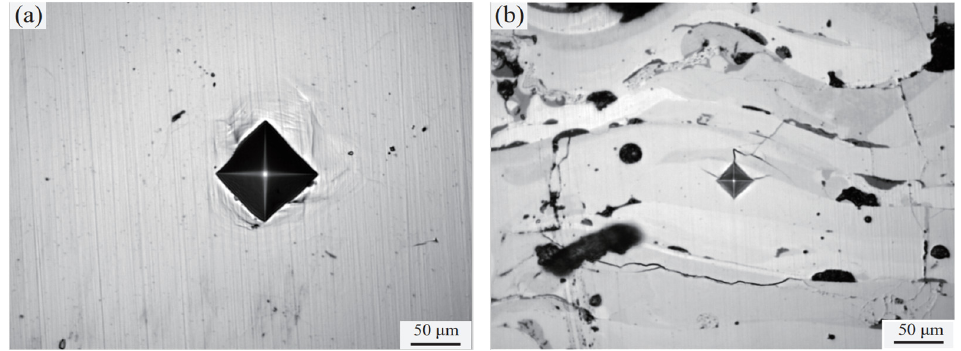
Figure 8. Cross-section hardness indentation ( a ) low-carbon steel; ( b ) Fe-based-Al 2 O 3 -B 4 C coating.